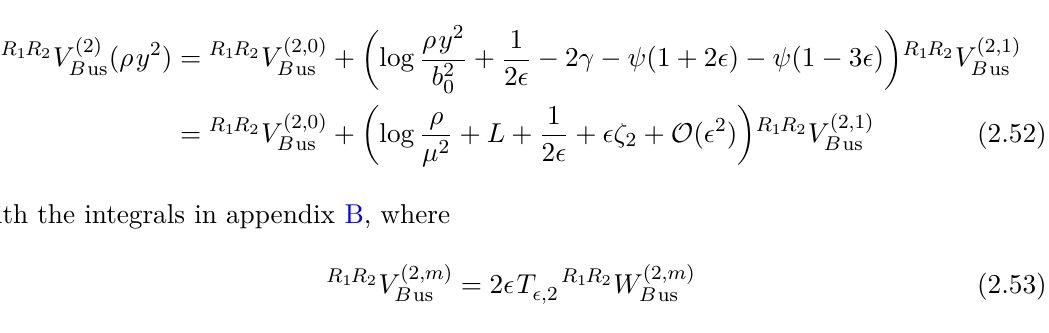
Figure 2 . Basic graphs for the soft factor at one loop. Full graphs are obtained by adding further disconnected eikonal lines as in figure 25 of [13]. The upper eikonal lines have direction v lower ones have direction v . The position vectors ξ and ξ 0 on either side of the final state cut are L purely transverse. They can be equal or